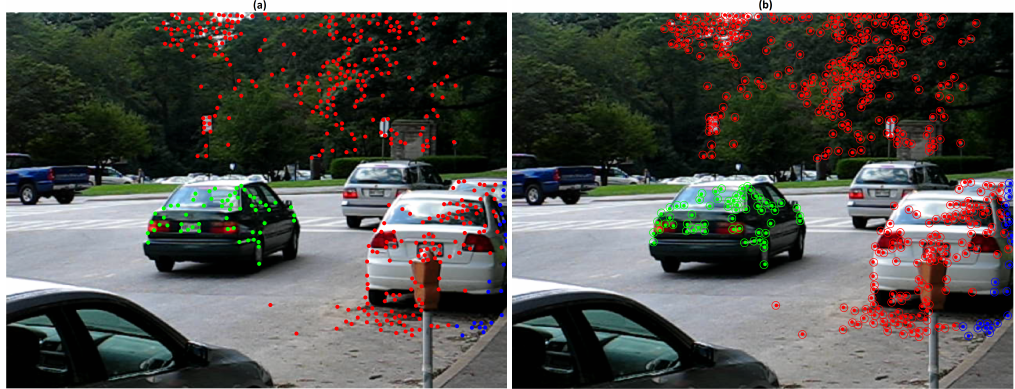
Figure 5. Baseline method results for Scene 3: ( a ) First frame segmentation; ( b ) Reprojection error.